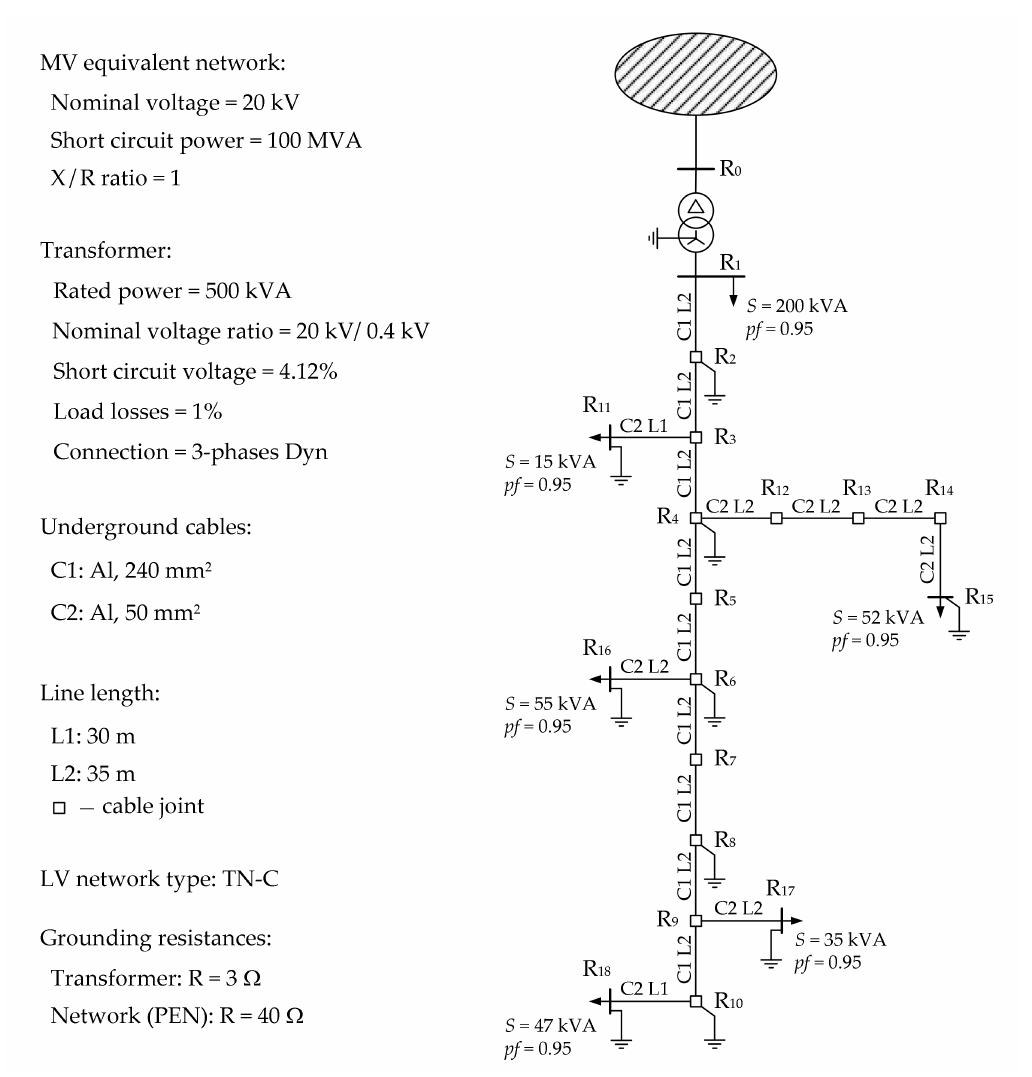
Figure 1. Diagram of the CIGRE LV test network for supplying residential consumers, showing component